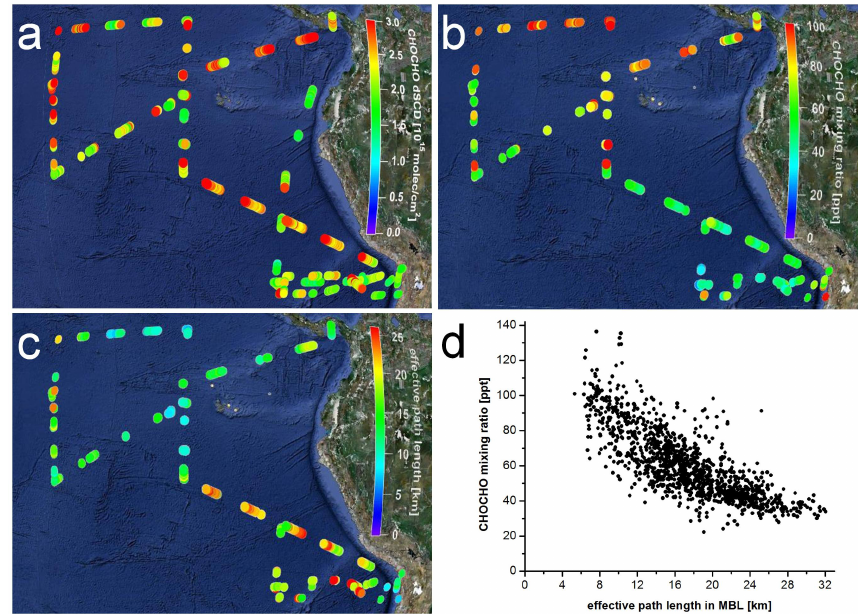
Fig. 3. Cruise plots (westerly of South America) of (a) CHOCHO dSCDs at 1.5 ◦ and 178.5 ◦ elevation angles, (b) CHOCHO volume mixing ratios (given in ppt) derived as described in Sect. 3.2, and (c) effective path length in the MBL (satellite underlay pictures: Google Earth). (d) Correlation plot of CHOCHO mixing ratio versus the effective path length, which shows an